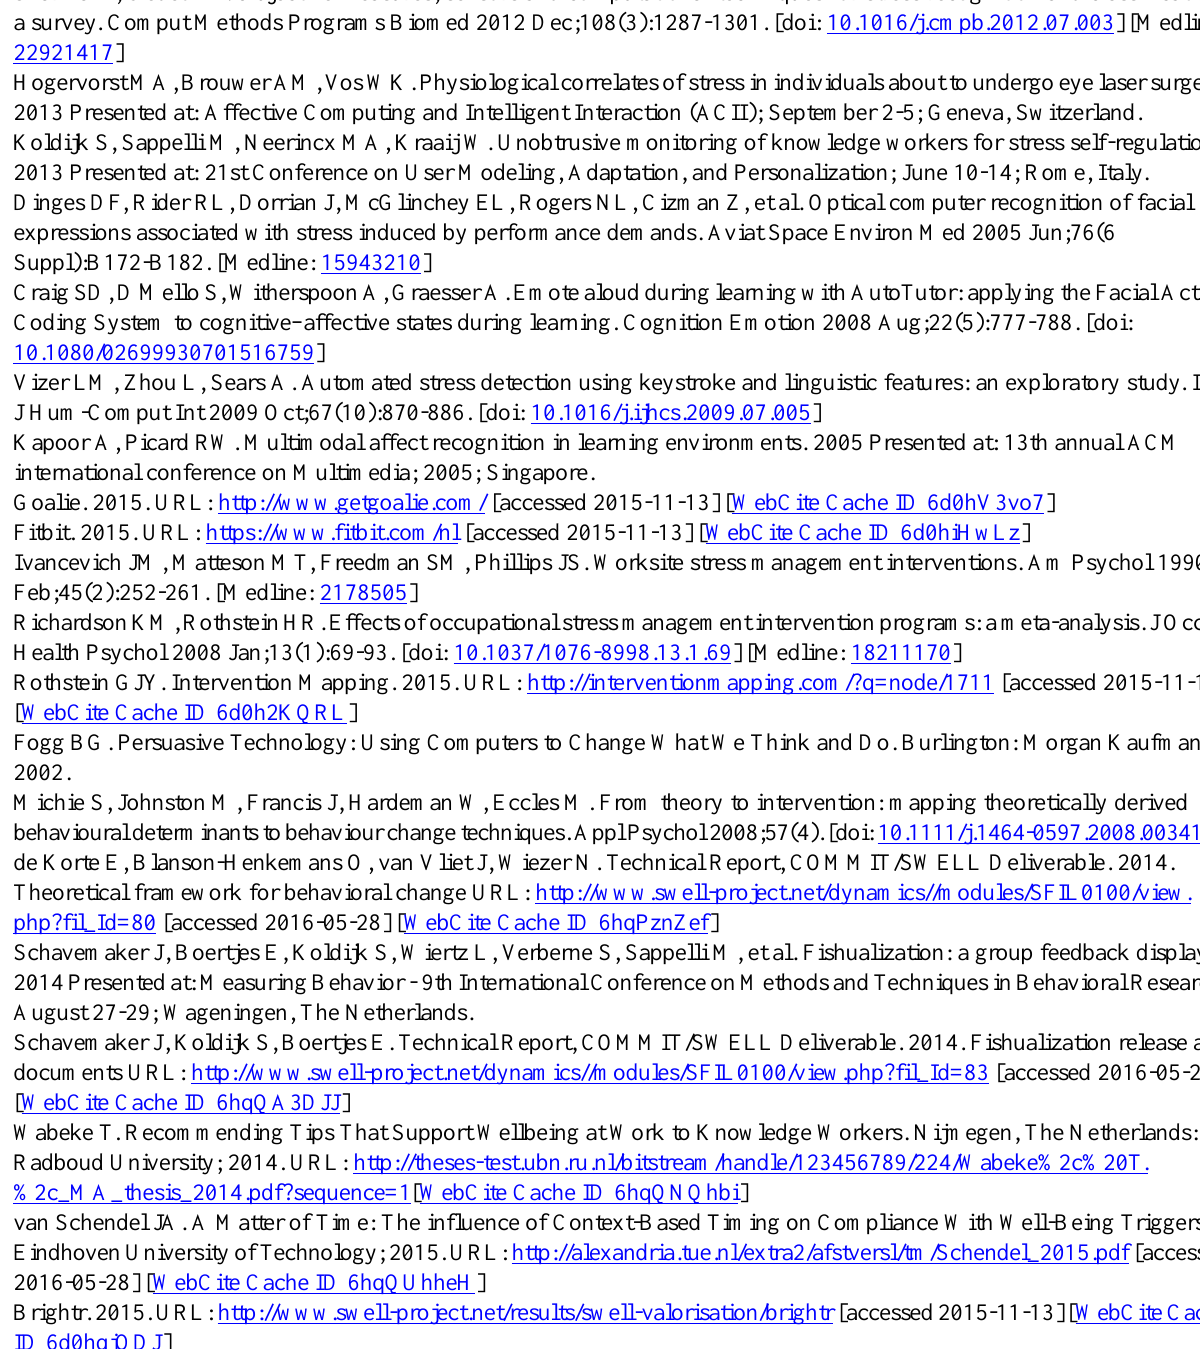
Abbreviations AWS: Areas of Worklife Scale e-coach: electronic coach E-R model: Effort-Recovery model ERI: Effort-Reward Imbalance model GPS: Global Positioning System JD-R model: Job Demands-Resources model P-E fit model: Person-Environment fit model SWELL: Smart Reasoning for Well-being at Home and at Work